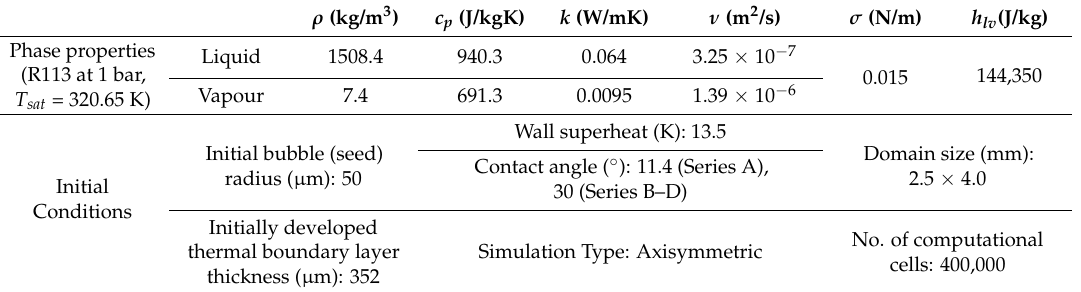
Table A1. Fluid properties and initial conditions (base case for R113, Series A–D).